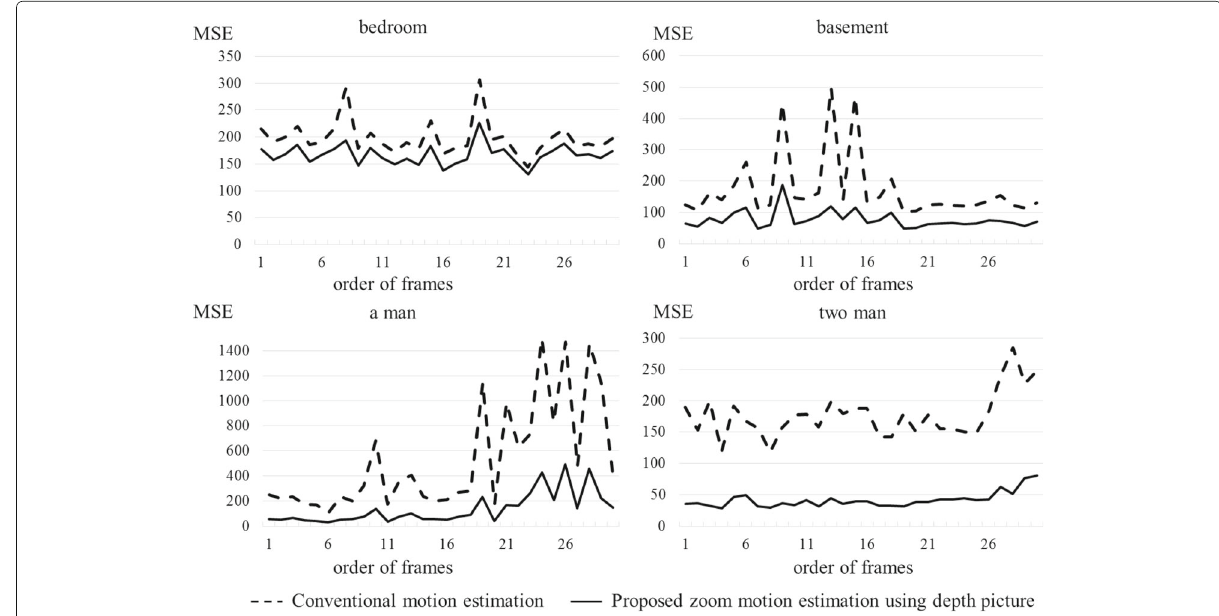
Fig. 14 Comparison of MSEs between conventional and proposed methods for depth videos (16 × 16 block